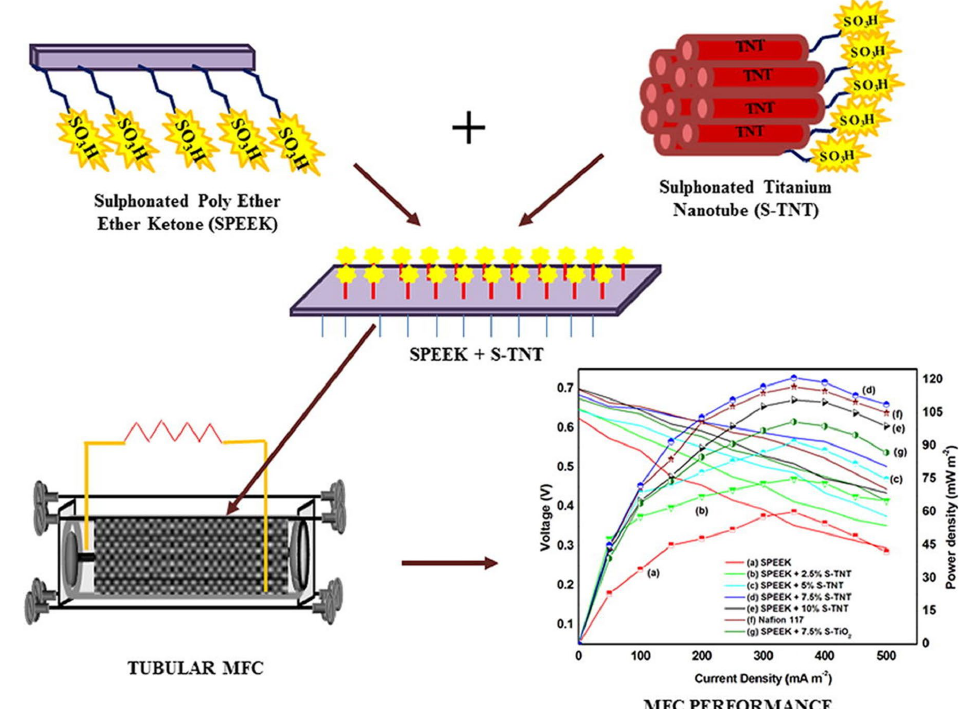
Figure 3. A schematic representation of sulfonated PEEK and STiO 2 nanotube composite membrane developments for tubular MFC and MFC performances (polarization curves and power density) of sPEEK, SPEEK with different ratios of STiO 2 nanotube (2.5, 5, 7.5, and 10%) membranes. Reproduced from [130], with permission from Elsevier, 2020.